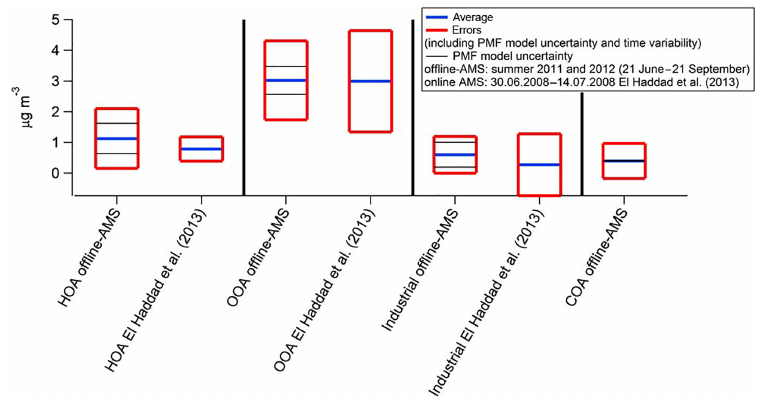
Figure 8. Online- (PM 1 ; El Haddad et al., 2013) and offline-AMS (PM 2 . 5 ) comparison for summer. For offline-AMS bars represent the error including temporal variability and model uncertainty. For online-AMS bars represents only the temporal